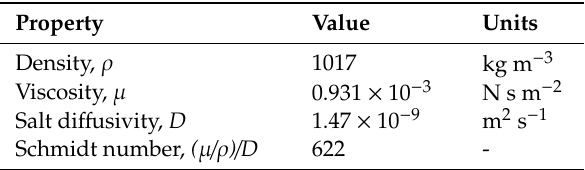
Table 4. Physical properties of the 500 mol / m 3 NaCl solution at 25 ◦ C.